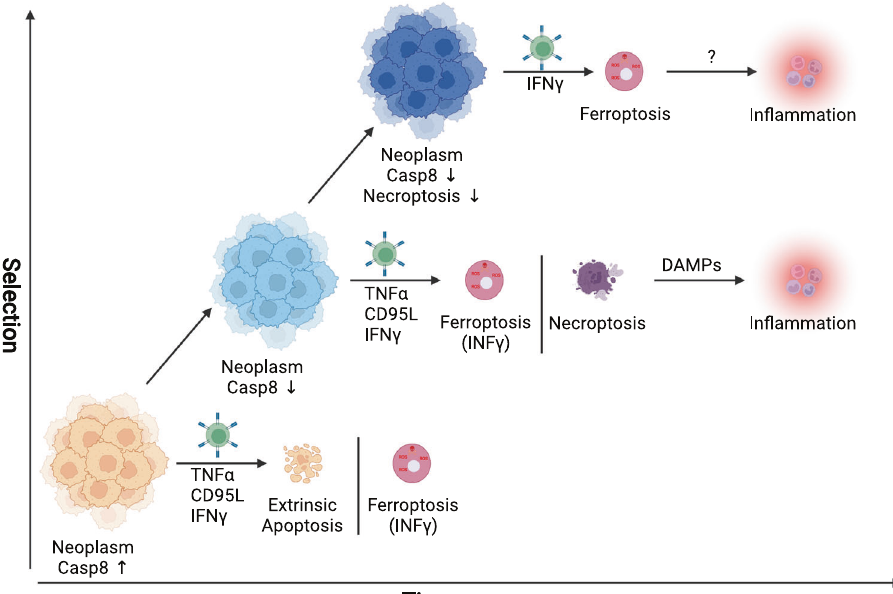
Fig. 2 Time-dependent cell death pathway plasticity in cancer evolution. Neoplasms expressing caspase 8 are sensitive towards the induction of extrinsic apoptosis by cytotoxic T-cells secreting TNF α , CD95L, or TRAIL. In addition, IFN γ is secreted, which may also sensitize tumor cells to ferroptosis via lipid remodeling. Evasion of extrinsic apoptosis via loss-of-function/expression of caspase 8 is commonly observed in neoplasms, yet it will render tumor cells more sensitive to induction of necroptosis, which, in turn, may lead to an in fl ammatory response via the release of danger-associated molecular patterns (DAMPs). Finally, persistent selective pressure may result in downregulation/ loss of necroptosis pathway components. Yet, this would leave IFN γ -induced sensitization towards ferroptosis intact. This fi gure was generated using fully licensed